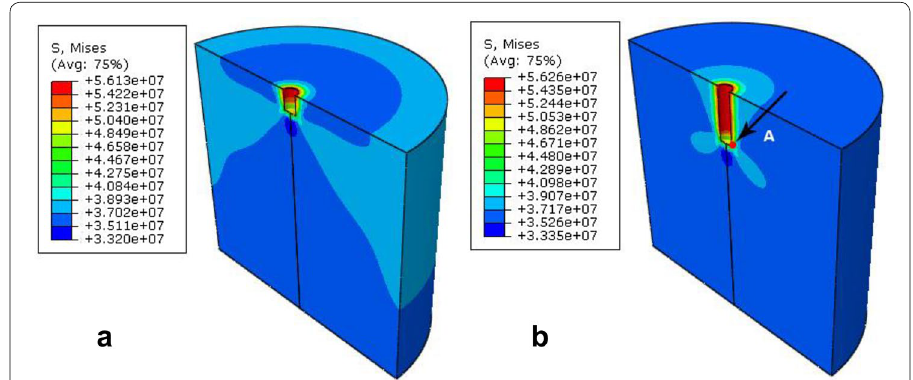
Fig. 6 Von Mises stress distribution caused by laser drilling at a lateral pressure of 32 MPa for dry limestone sample in a time of 10 s ( a ) and 25 s ( b